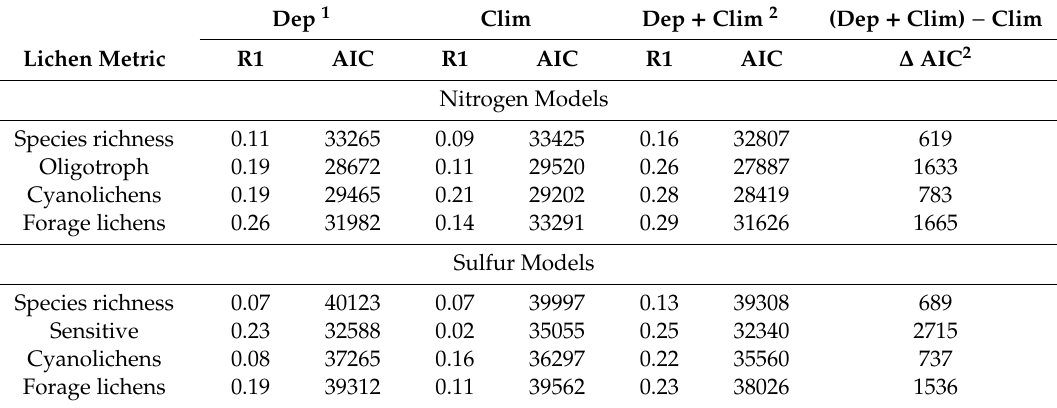
Table 2. Goodness of fit statistics and improvements in AIC for 90% quantile regression models demonstrate a higher predictive value of deposition with climate compared to climate alone. Smaller AICs indicate better fit ( ∆ AIC must be > 25). The larger the ∆ AIC, the more improvement in the model compared to other models for that metric. R1 measures absolute model fit whereas AIC measures the relative fit of nested models (i.e., models in the same row). Model predictor variables: Dep = deposition only, Clim = all climate variables only, Dep + Clim = deposition and all climate variables.